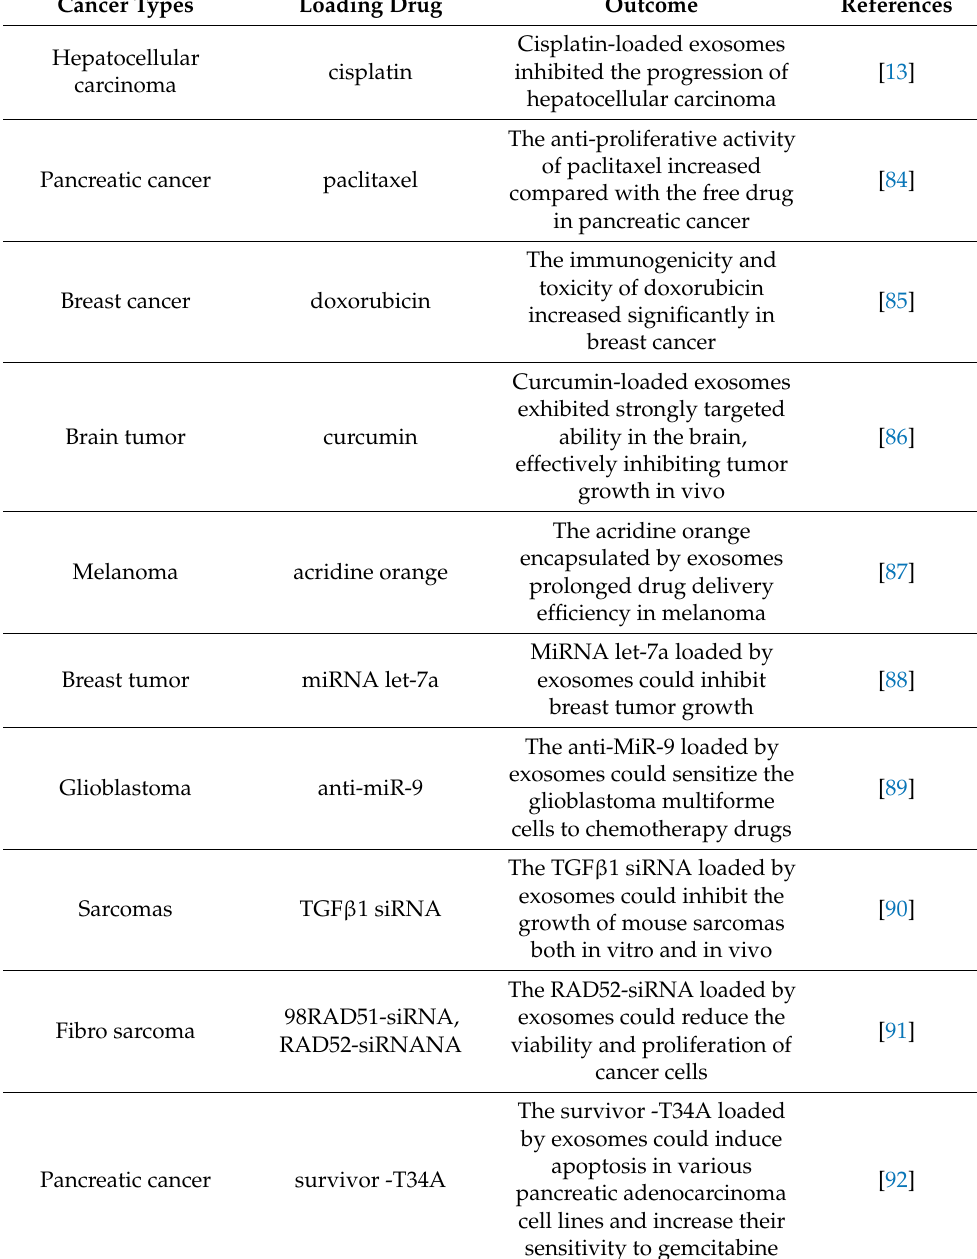
Table 2. The applications of exosomes as drug